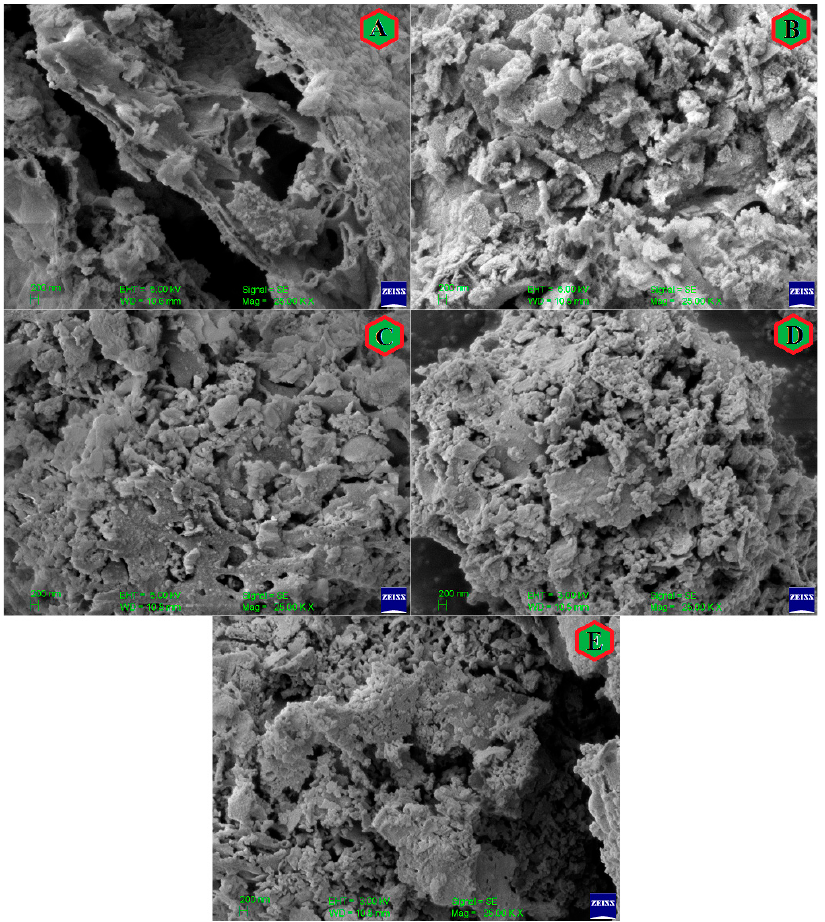
Figure 5. SEM images of CoCr 0.5 Dy x Fe 1.5-x O 4 where ( A ) x = 0.0, ( B ) x = 0.025, ( C ) x = 0.050, ( D ) x = 0.075 and ( E ) x = 0.1.